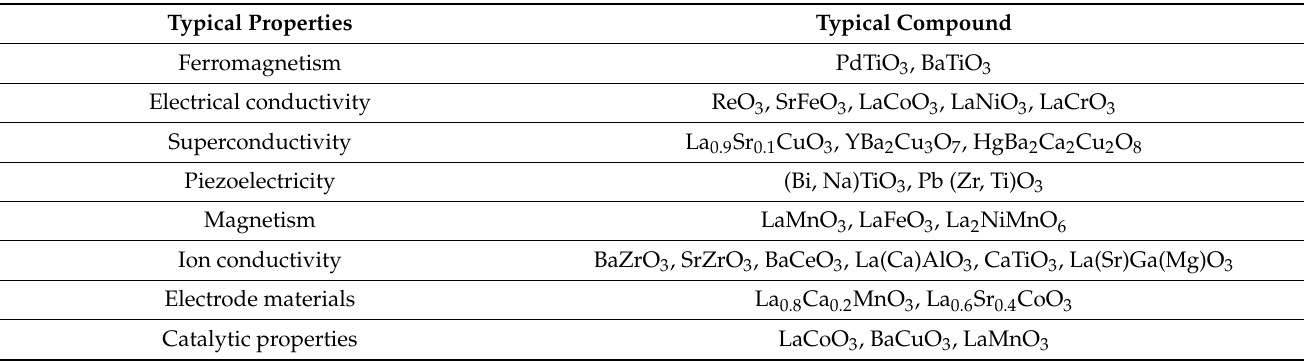
Table 2. Typical perovskite oxide properties.